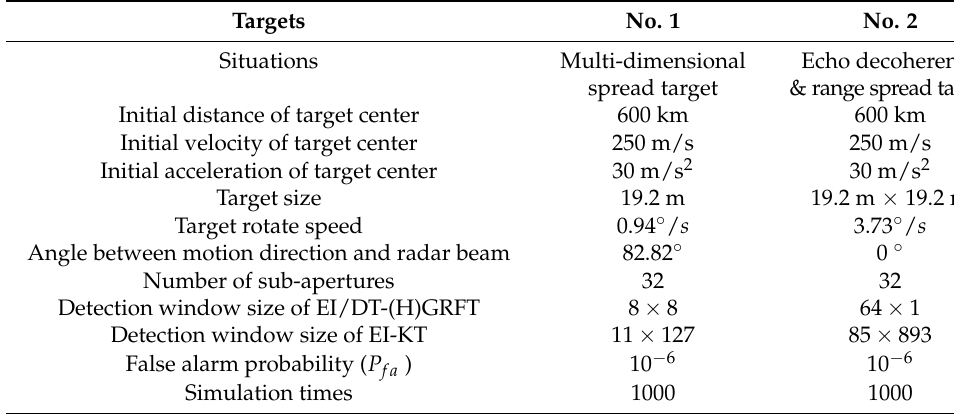
Table 2. Target Parameters & Processing